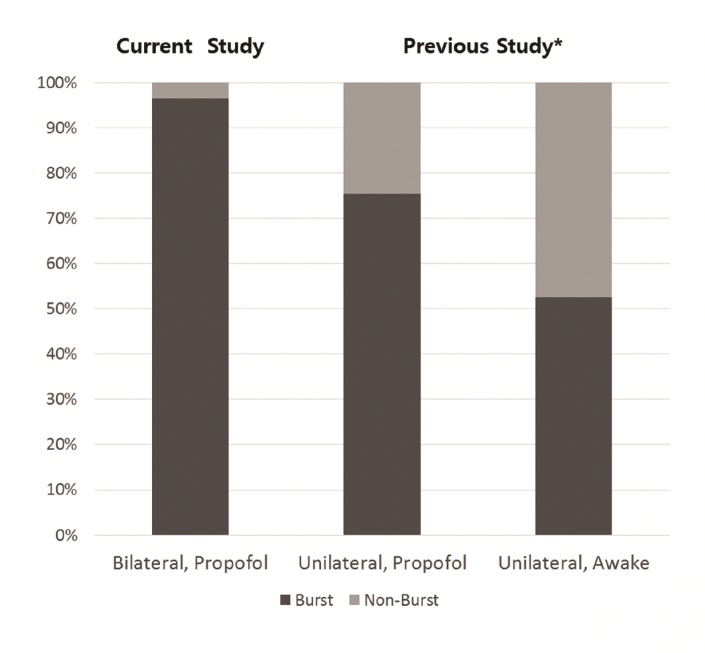
The proportion of burst and non-burst discharges.*Kim et al., 20148.